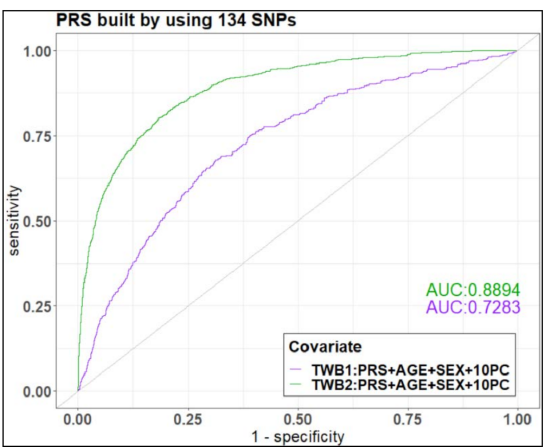
Figure 3. Receiver Operating Characteristic (ROC) curves for the polygenic risk score (PRS) model, PRS_TWB2.0 model, after adjustments for age, sex, and 10 principal components (PCs). The PRS_TWB2.0 model is a PRS model built by 134 SNPs from the TWB2.0 cohort to identify glaucoma cases in the Taiwan Biobank 2.0 (TWB2.0) (green curve) and TWB1.0 (purple curve, for validation)